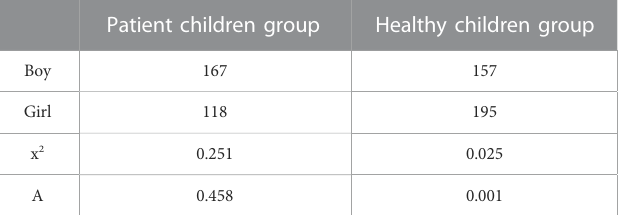
TABLE 1 Analysis of gender differences between the two groups of